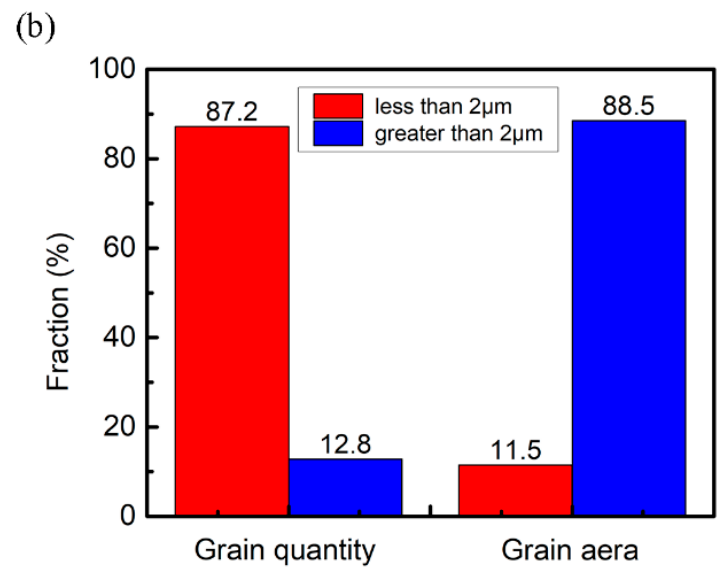
Figure 7. ( a ) The EBSD image of the element test area; ( b ) Grain size statistics.